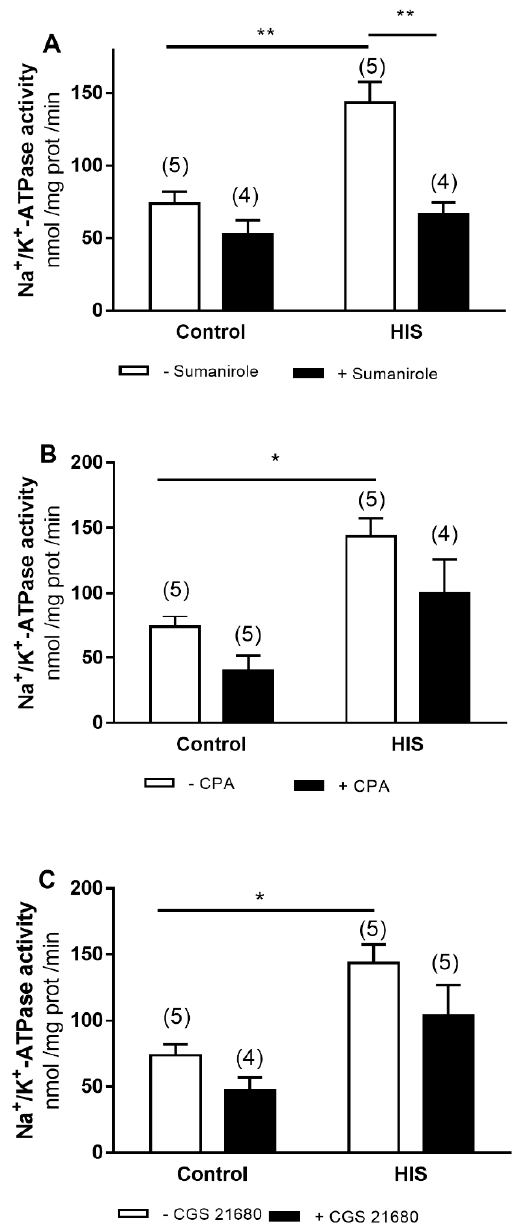
Figure 2. Effects of D 2 dopamine ( A ), adenosine A 1 ( B ) and A 2A receptors ( C ) activation on Na + /K + ATPase activity in neonatal cortex 20 days after HIS (PD 32). The activity of Na + /K + ATPase was measured in control rats (PD 32) and after HIS (PD 32), following the protocol described in the Ma- terials and Methods section. To evaluate the influence of D 2 dopamine, adenosine A 1 and A 2A recep- tor activation on Na + /K + ATPase activity, the corresponding plasma membranes were preincubated for 6 min at 30 °C with 140 μ M of sumanirole, 140 μ M of CPA and 140 μ M of CGS 21680, respec- tively. Each bar represents the mean ± SEM for the indicated n value. * p < 0.05, ** p < 0.01 using a two-way ANOVA and Bonferroni’s post hoc test. 2.3. Modulation of Na + /K + -ATPase Activity by Ionotropic Glutamate Receptor after HIS To evaluate the effect of ionotropic glutamate receptor, we used AMPA and NMDA, selective agonists of the different types of the corresponding ionotropic receptors. The two-way ANOVA analyses revealed that both HIS and agonists [NMDA: F(1,14) = 4.729,